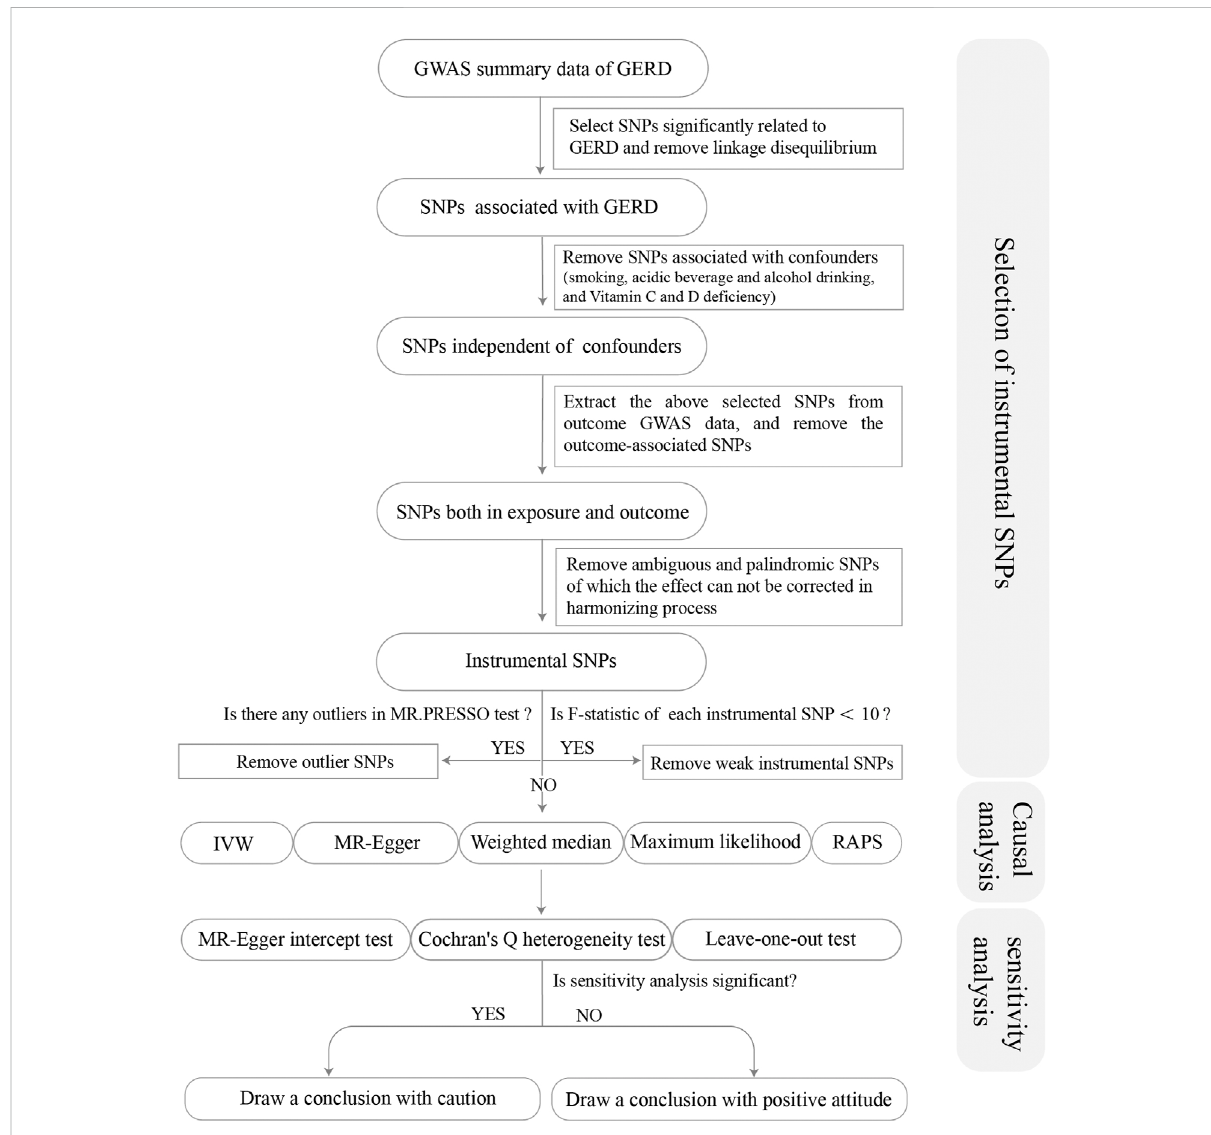
FIGURE 1 Flow chart about the analytical methods and how the MR analysis was performed